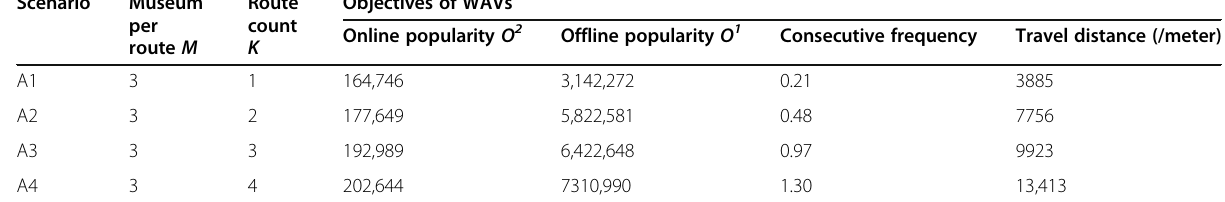
Table 1 Objective of WAV routes departing from Amsterdam Central Station Scenario